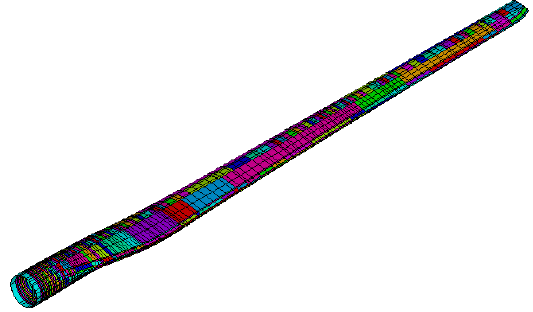
Figure 5. Real constant distribution of the blade.